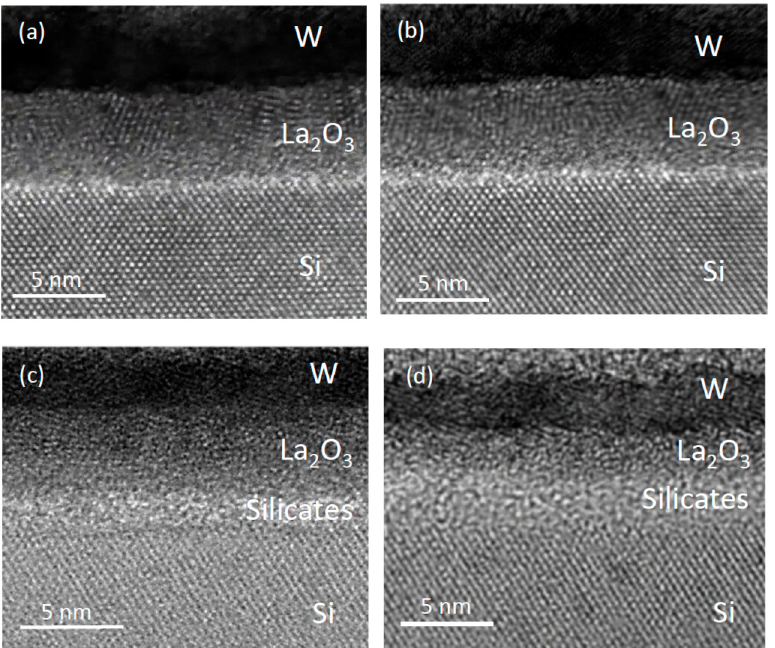
Figure 1. Transmission electron microscopy (TEM) picture of ( a ) as-deposited La 2 O 3 film; ( b ) with 300 °C annealed, ( c ) 500 °C annealed and ( d ) 600 °C annealed sample. Samples with 500 °C and 600 °C annealing show significant growth in interface roughness and interface silicate layer.